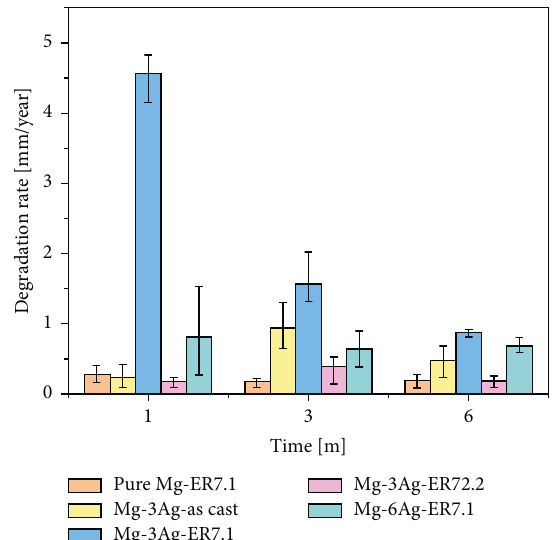
Figure 13: Degradation rate for pure Mg and Mg-Ag alloys in vivo